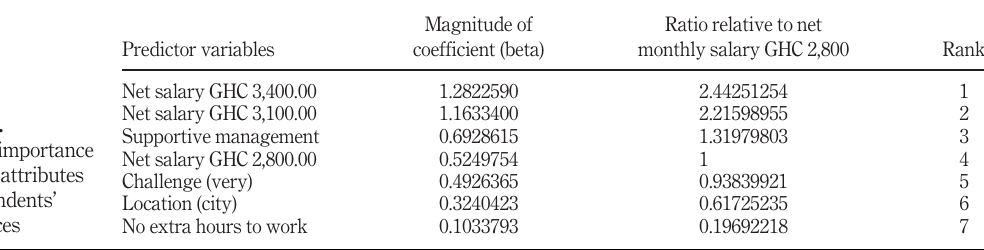
of career attributes on respondents